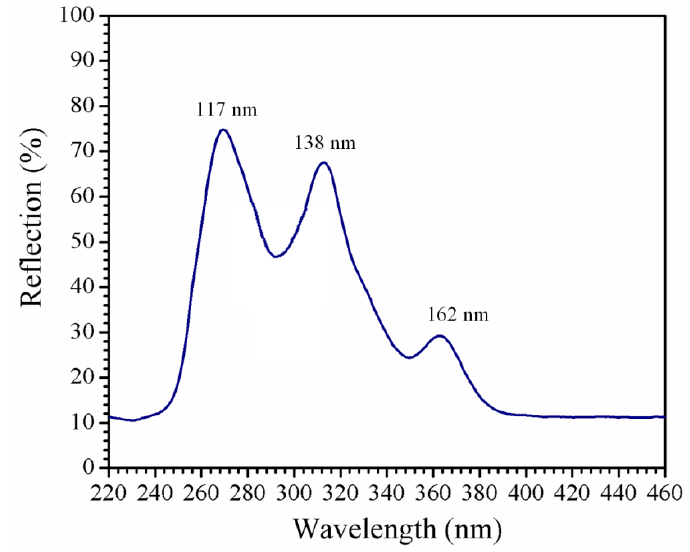
Figure 5. Di ff raction property of the CC coating sample combining 117-nm, 138-nm and 162-nm Figure 5. Diffraction property of the CC coating sample combining 117-nm, 138-nm and 162-nm PMMA PMMA colloids.